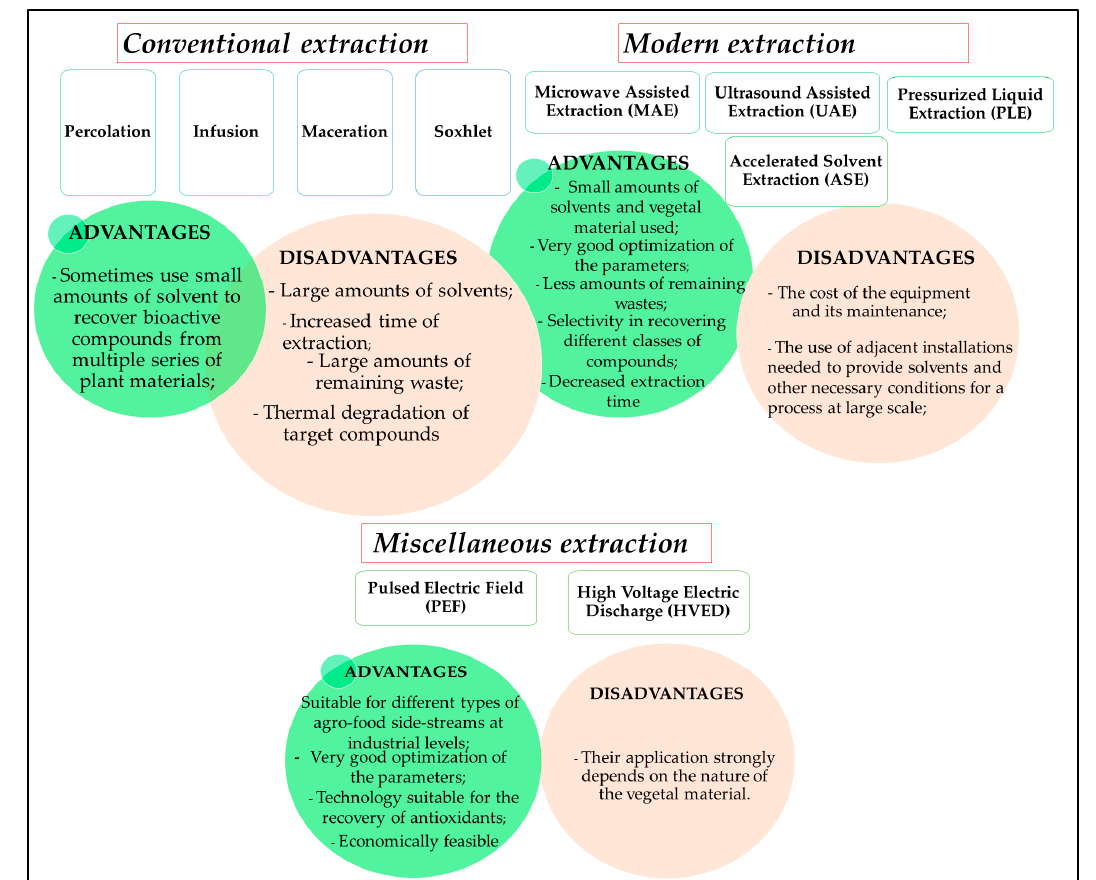
Figure 2. Schematic presentation of the extraction methods .